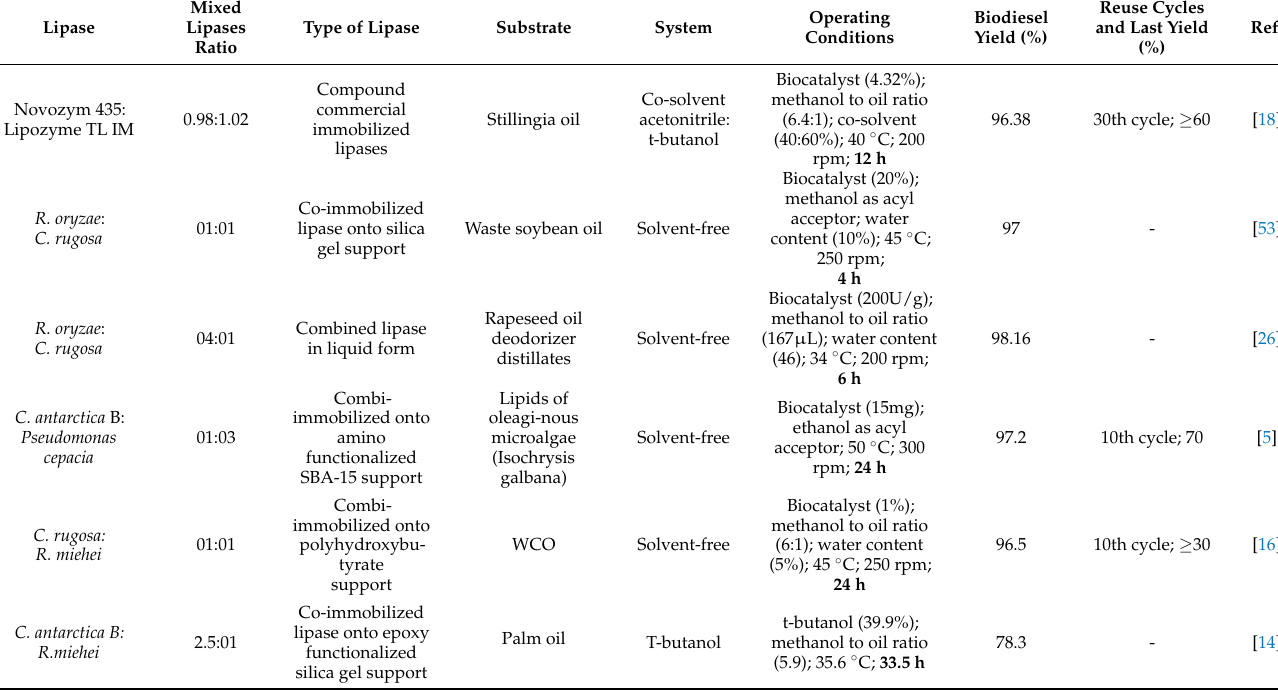
Table 2. Comparison of transesterification reaction parameters on biodiesel yield and reuse cycle between co-immobilized ROL and CRL-mMWCNTs@4-arm-PEG-NH 2 and other individual and mixtures of immobilized lipases.